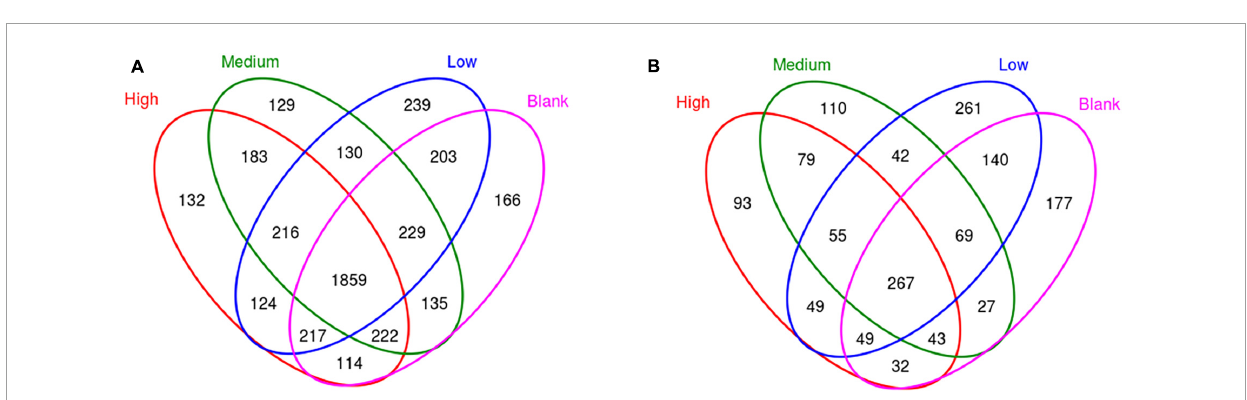
FIGURE1 Schematic diagram of the sampling location and gamma radiation absorption dose rate.